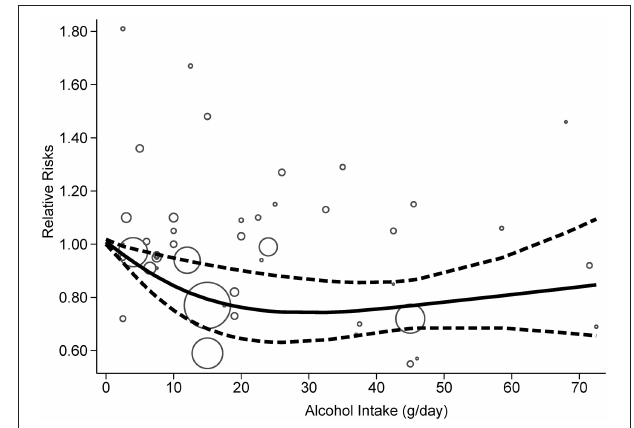
FIGURE 3 | Begg’s funnel plot for the relationship between PD risk and alcohol consumption. FIGURE 4 | Dose-response relationships between PD risk and alcohol